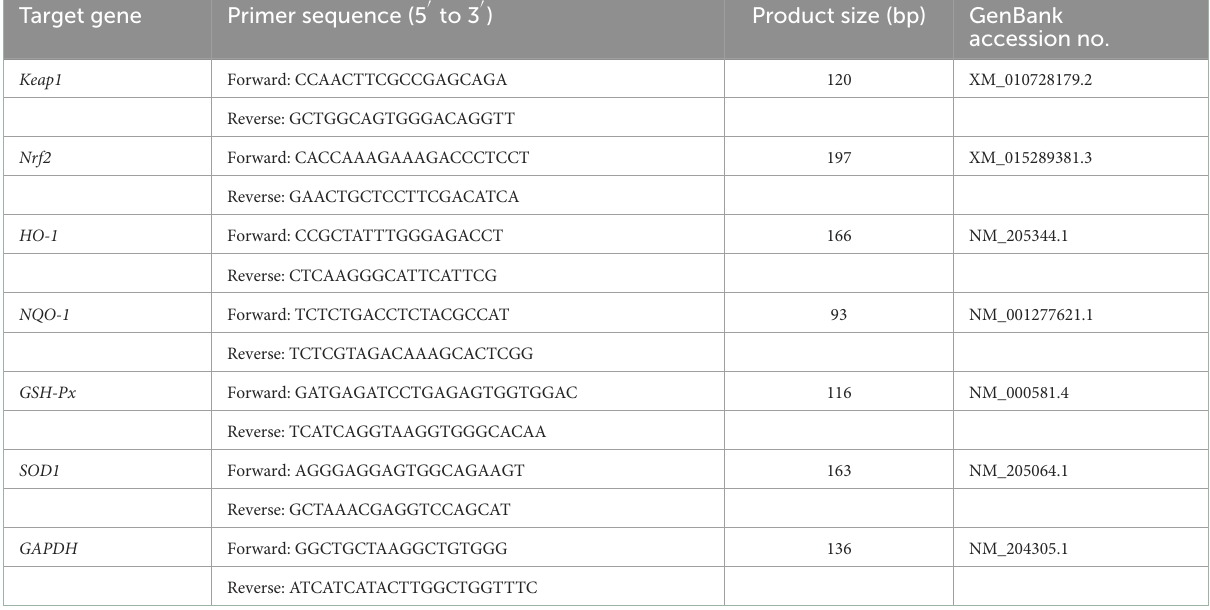
TABLE 2 Sequence of primers for real-time PCR.